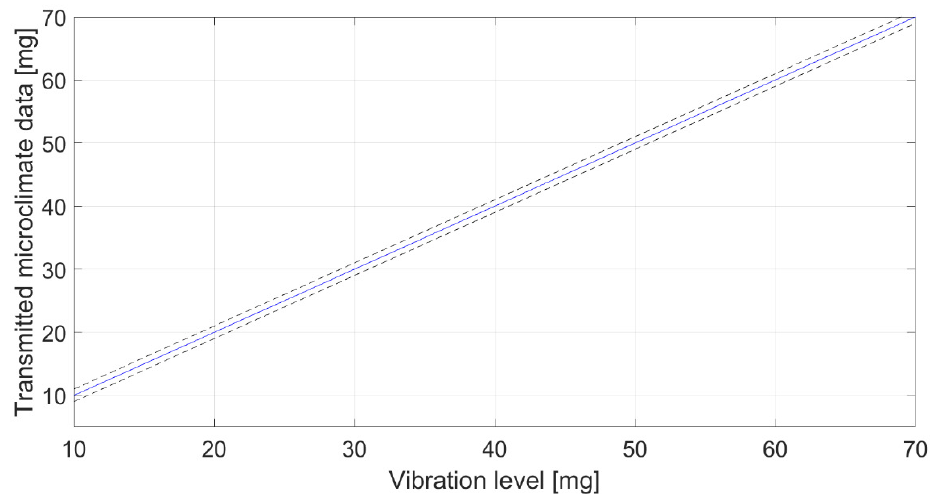
Figure 8. Characterization in terms of vibrations.